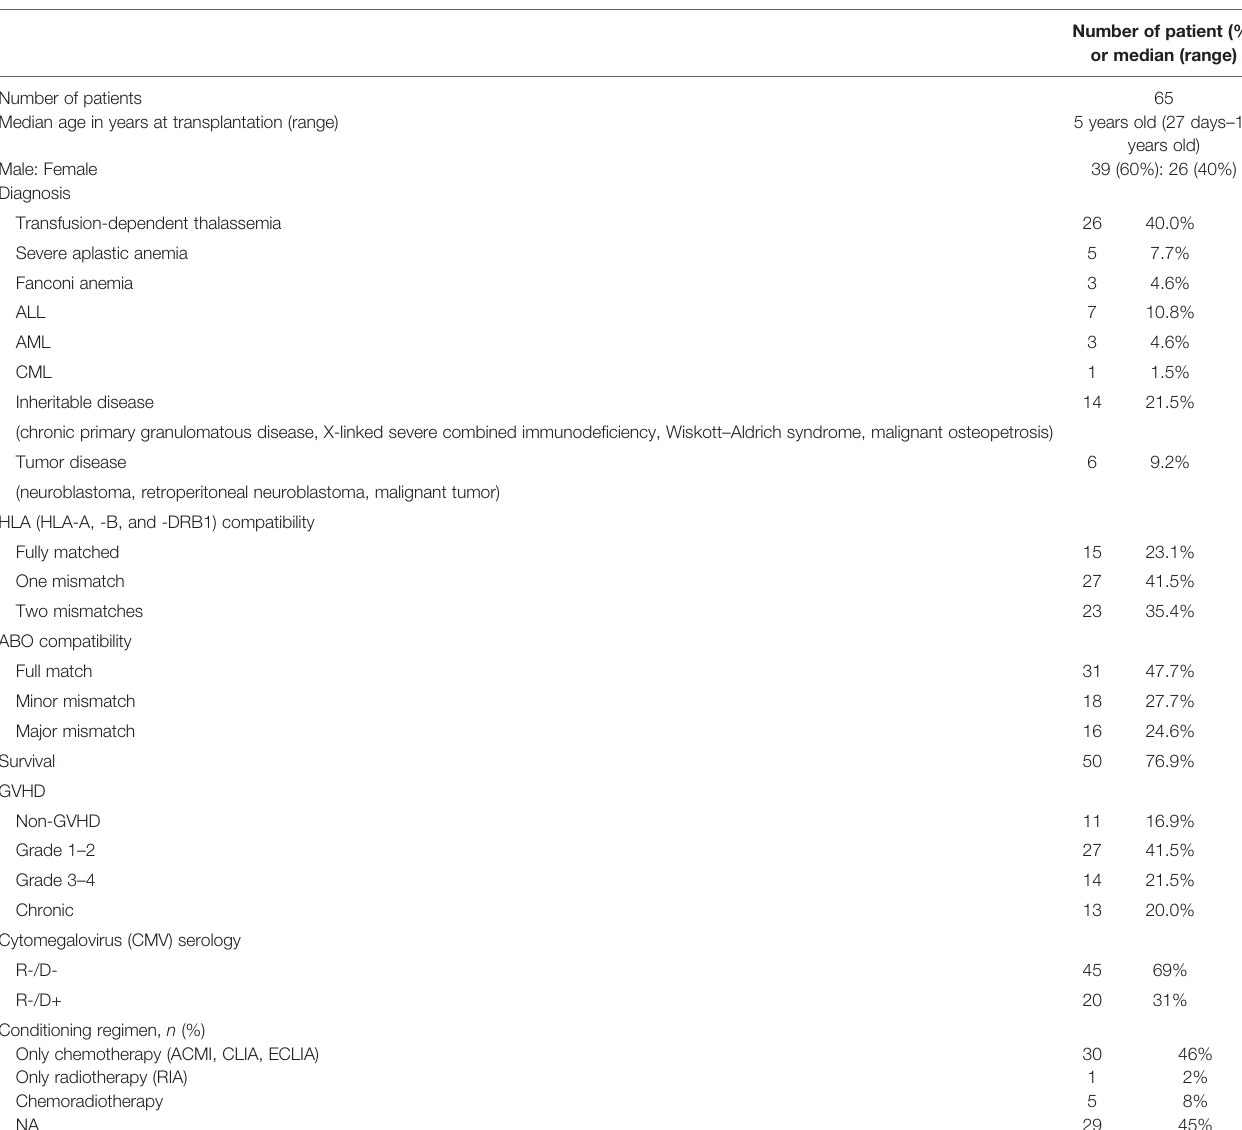
Number of patient (%) or median (range)